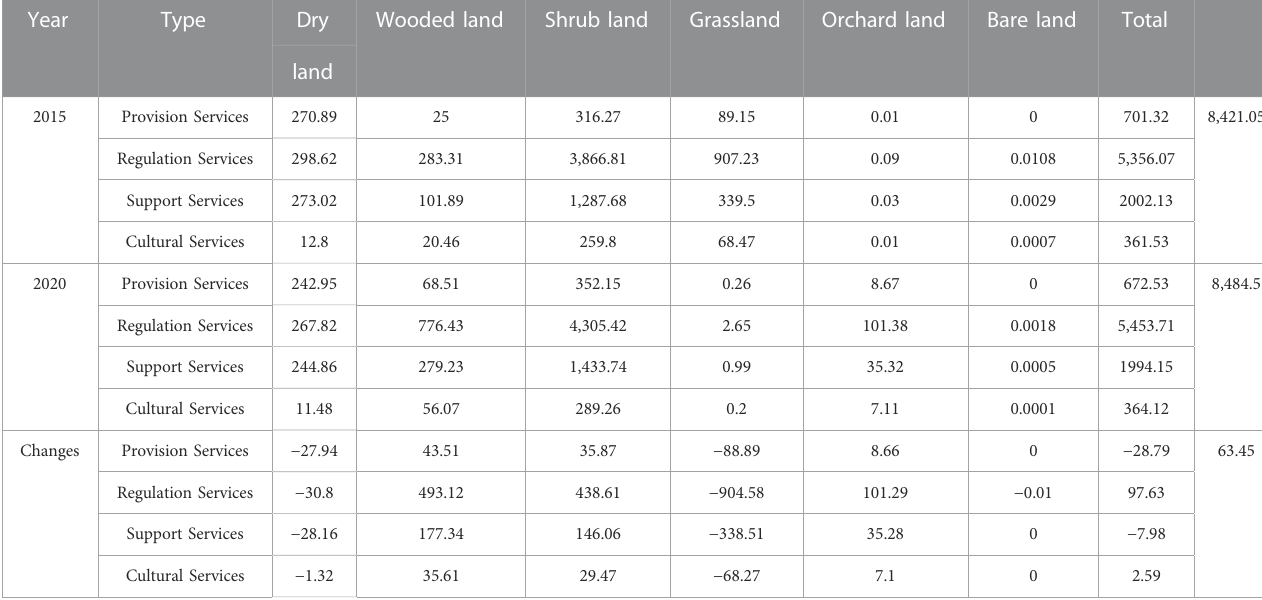
TABLE 7 Value of ecosystem services in the study area (CNY/10 4